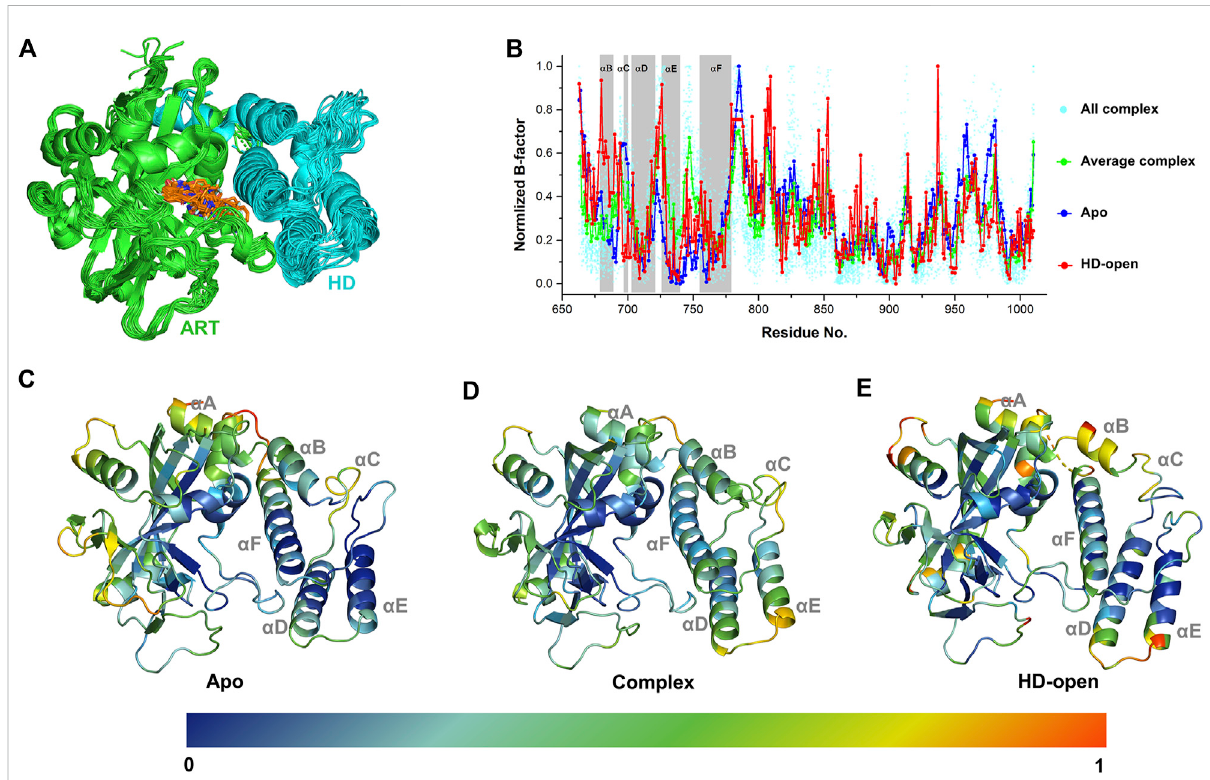
FIGURE 1 The dynamic characteristics of different conformational states of PARP-1 by B-factor analysis. (A) Superposition of 33 PARP-1 complex crystal structures with the existence of ART domain (green) and HD (cyan). The co-crystalized ligands are overlapped in orange sticks. (B) The normalized B-factors of apo, complex, HD-open states of PARP-1. The normalized B-factors of 33 complex structures (cyan dot) were averaged and shown in green line. (C) Theconformational fl exibilityofapostate,represented bythecrystal structure (PDBID:4DQY). (D) Theconformational fl exibility of complex state, represented by the crystal structure (PDB ID: 4R6E). (E) The conformational fl exibility of HD-open state, represented by the crystal structure (PDB ID: